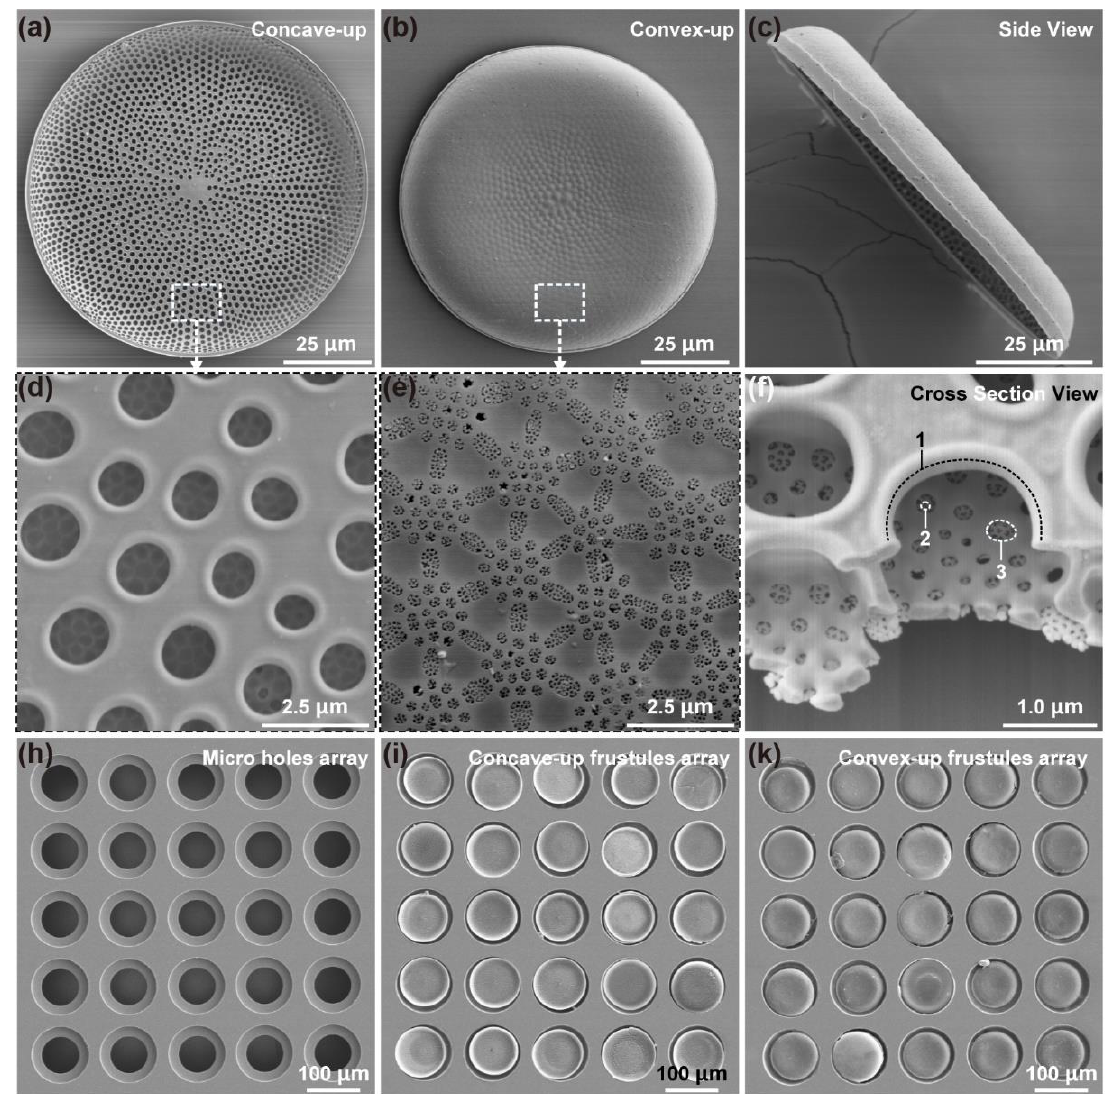
Figure 1. The morphology and array of C. sp. frustules. ( a ) The concave side with evenly distributed ~1 μm pores; ( b ) The convex side with uniformly distributed ~200 nm and ~40 nm pores; ( c ) The side view of a diatom frustule indicating the height is about 10 μm; ( d ) The detailed morphology of the concave side; ( e ) The detailed morphology of the convex side; ( f ) The cross section of a diatom frustule, where three layers of pores can be clearly observed. ( h ) SEM images of the step holes; the diameters are 115 μm and 75 μm, and center distance is 138 μm. The depth of the bigger hole is around 10 μm. ( i ) Concave-up frustules array and ( k ) convex-up frustules array, in which each frustule is bonded with the Si substrate by hot-melt glue.